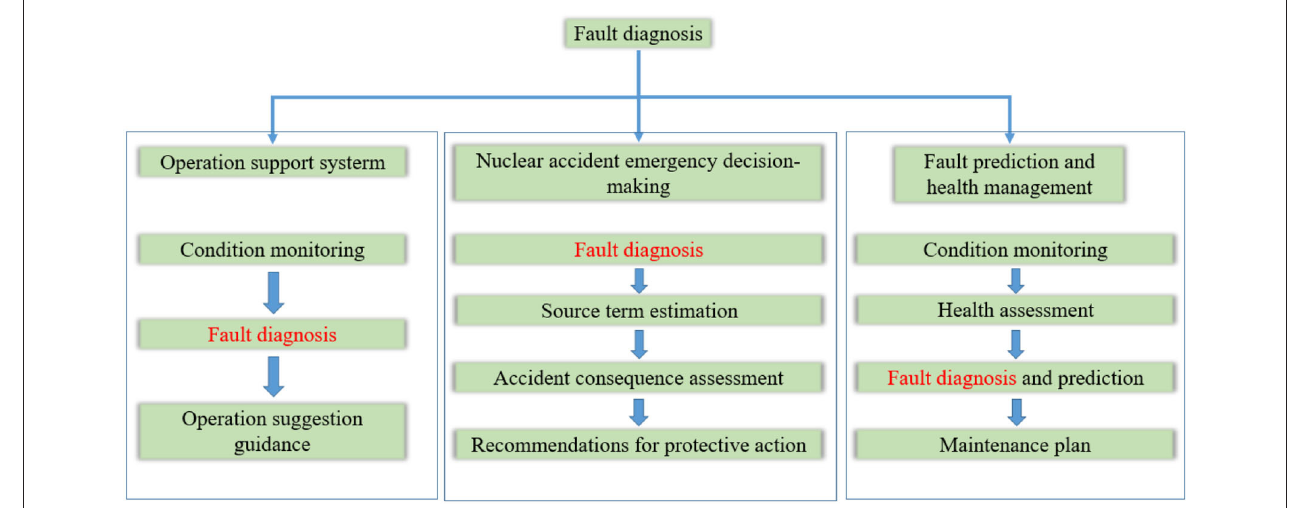
FIGURE 1 | Application of fault diagnosis in Nuclear power plants